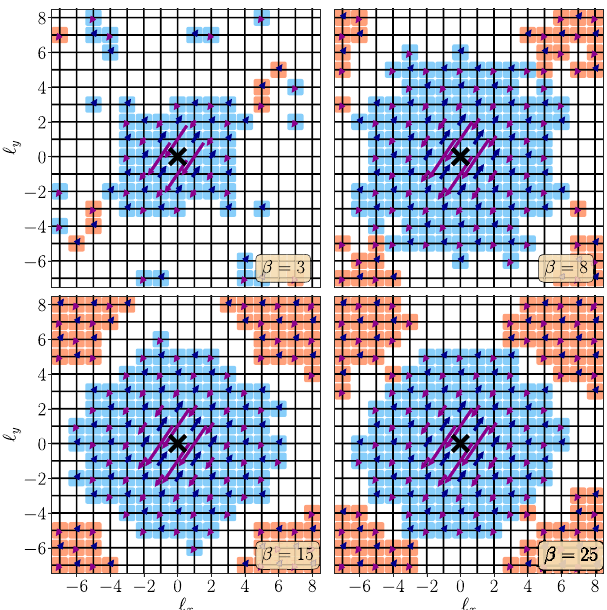
FIG. 7. Evolution of the spin correlation function C s ð l x ; l y Þ as T is lowered. The results are for a 16 × 16 square lattice with U ¼ 8 and δ ¼ 1 = 8 doping, at four T values as labeled (in β ).